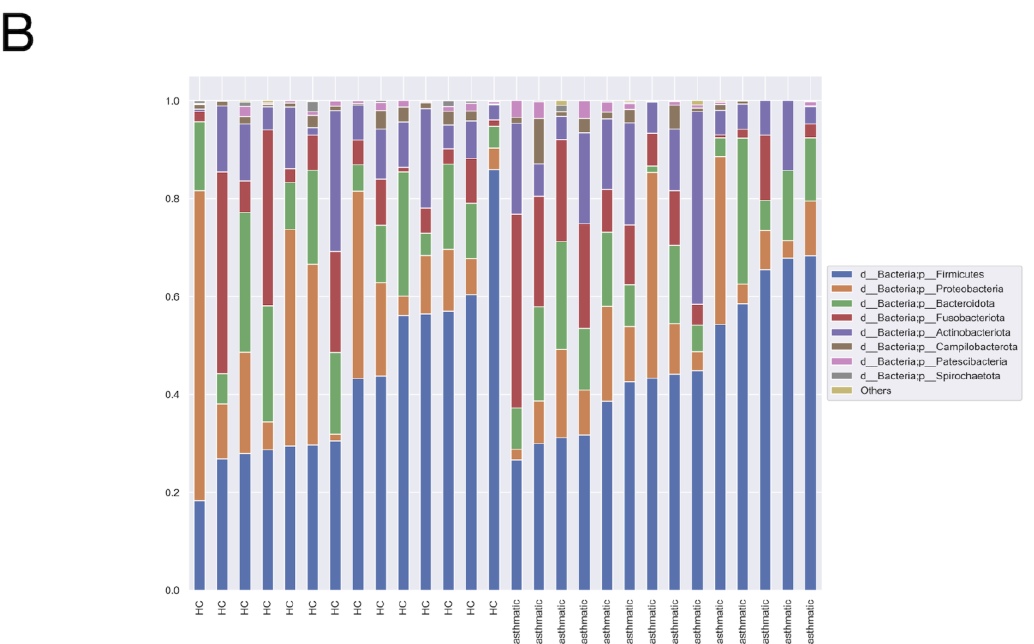
Figure 6. The relative abundance at the phylum level in lower airways—EBC samples ( A ); in upper airways—swab samples ( B ). d_—domain, p_—phylum.